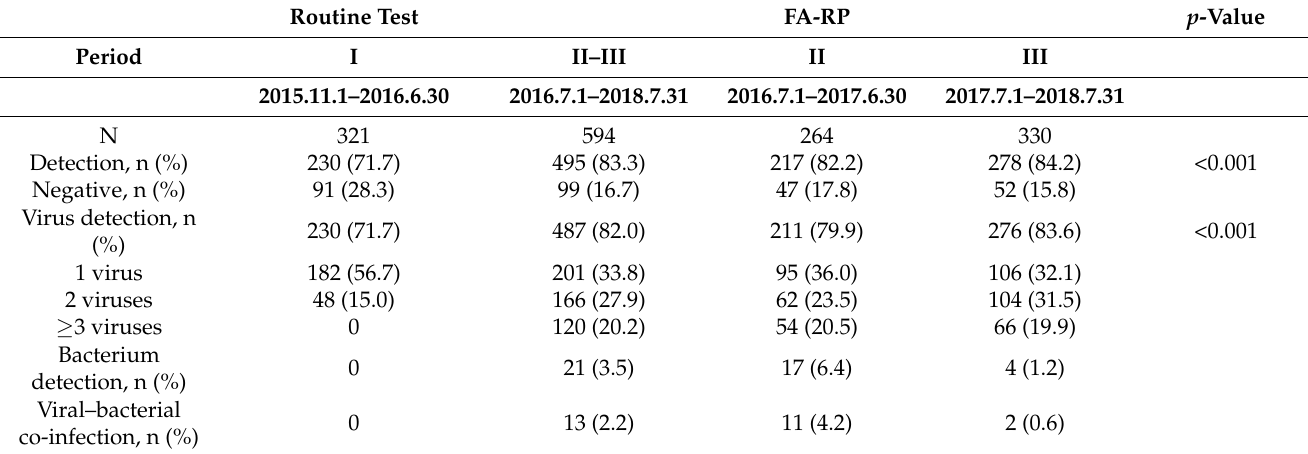
Table 2. Comparison of virus detection between periods.